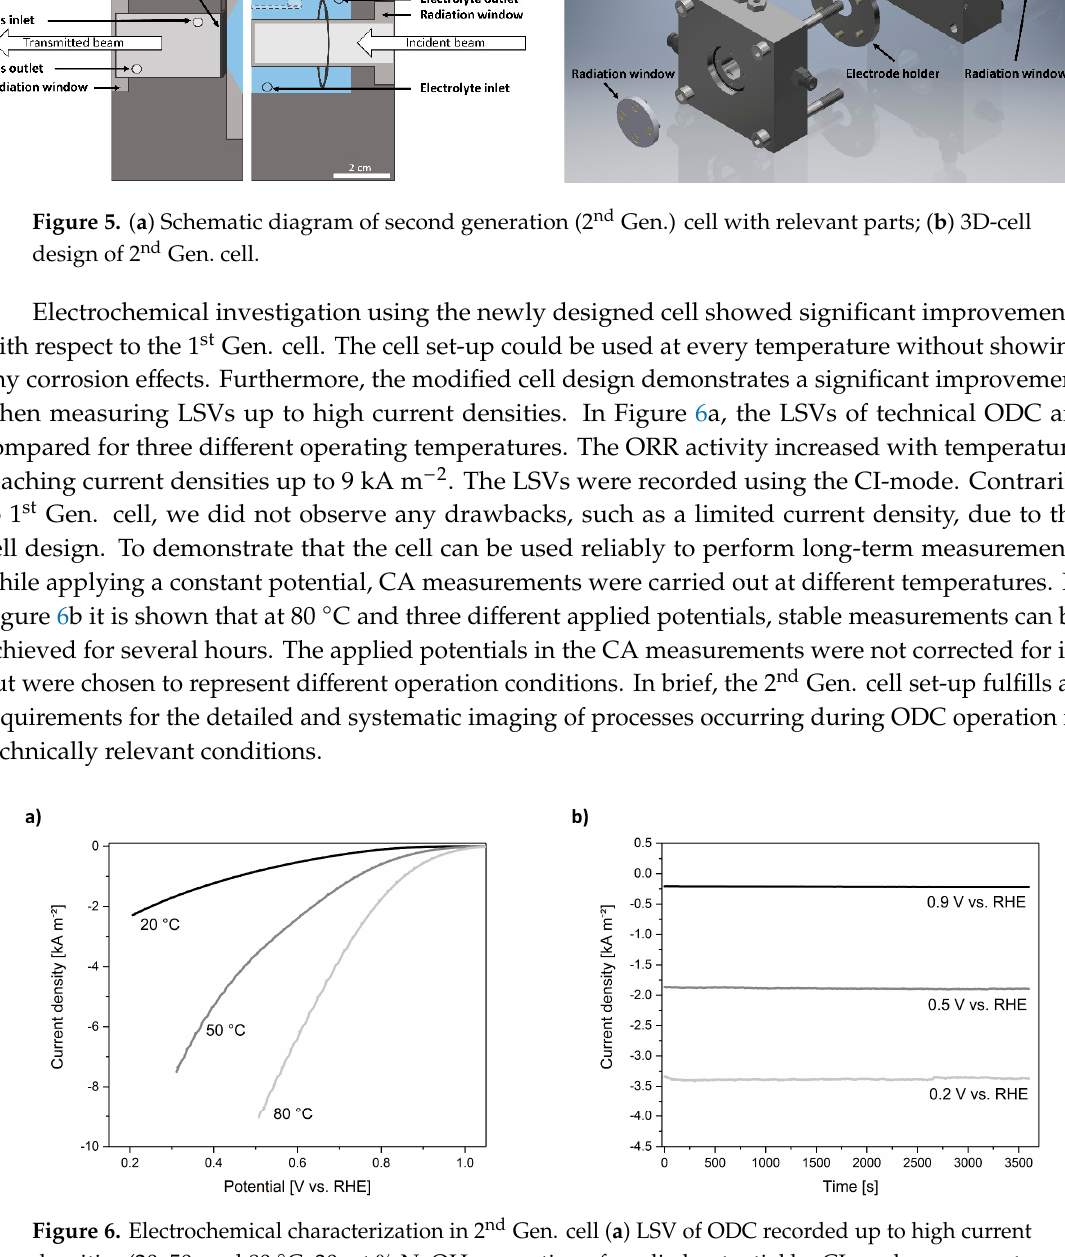
Figure 6. Electrochemical characterization in 2 nd Gen. cell ( a ) LSV of ODC recorded up to high current densities (20, 50, and 80 °C, 30 wt.% NaOH, correction of applied potential by CI-mode, sweep rate 2 mV s -1 ); ( b ) Chronoamperometry (CA) at 0.2, 0.5, and 0.9 V vs. RHE (80 °C, 30 wt.% NaOH, no iR- correction) showing very stable features.